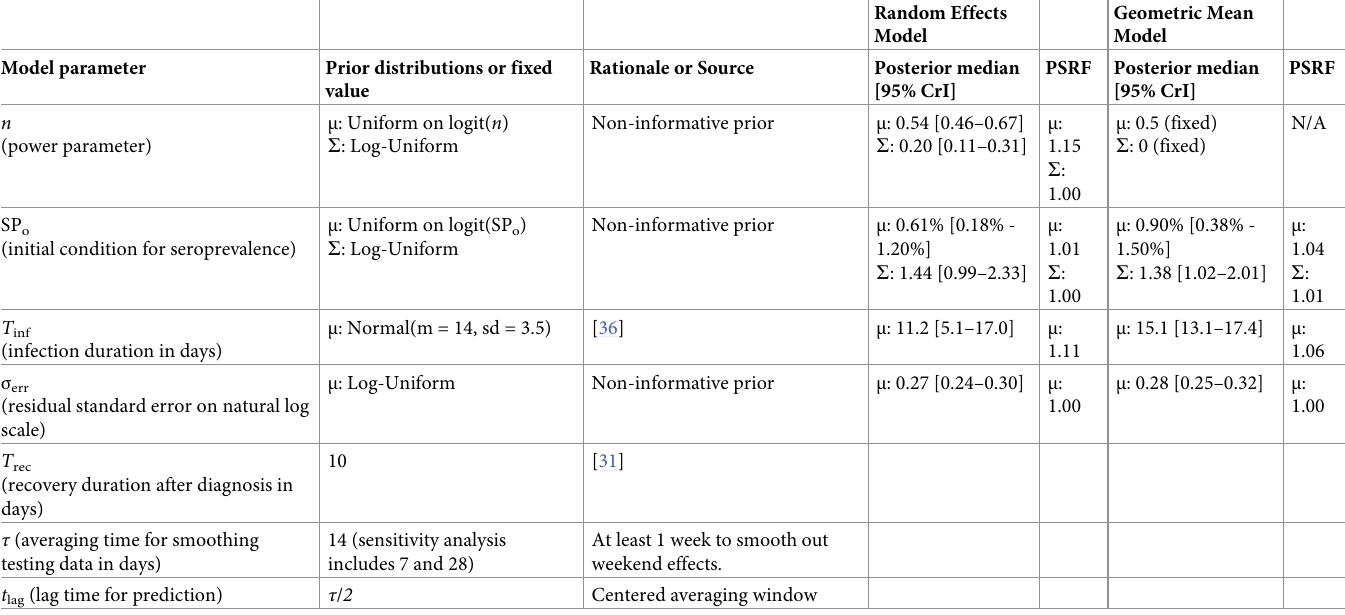
Table 1. Model parameters, prior and posterior distributions, and convergence